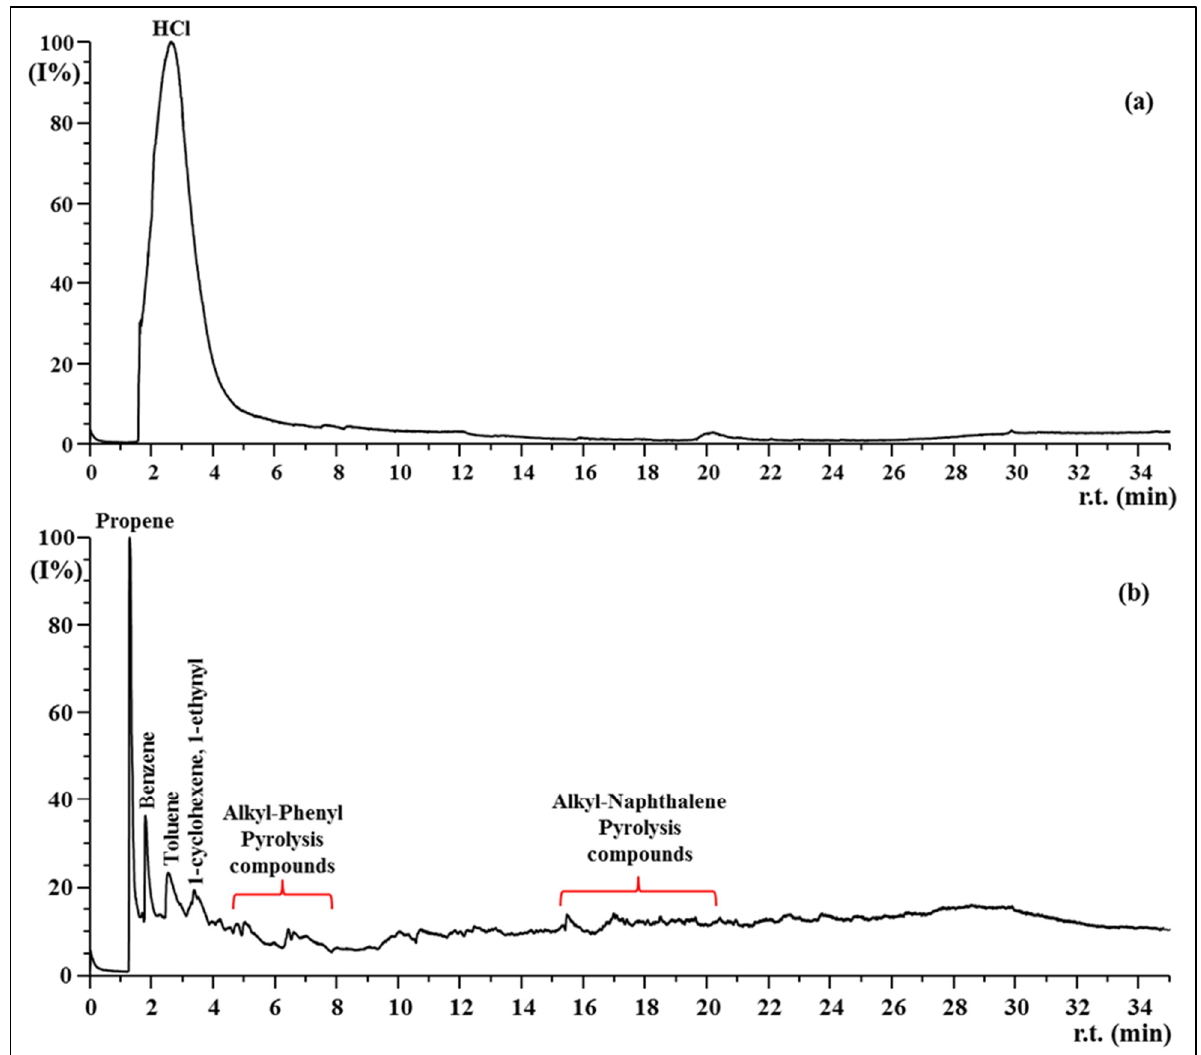
Figure 9. Py-GC/MS pyrograms of the thermal products of the unplasticized PVC (UPVC) recorded at ( a ) 300 °C and ( b ) 450 °C. at ( a ) 300 ◦ C and ( b ) 450 ◦